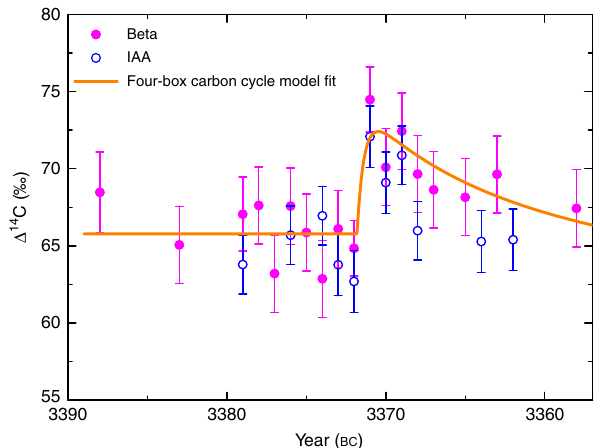
Fig. 1 Measured 14 C content. Measured results of Δ 14 C for the tree rings using the AMS method at the Beta Analytic radiocarbon dating laboratory ( fi lled circles) and the Institute of Accelerator Analysis laboratory (open circles). The typical error of a single measurement is about 2.5 ‰ for fi lled circles and 2.0 ‰ for open circles. In order to obtain a smaller error for this 14 C increase event, several measurements for BC 3371 and BC 3372 are performed. The solid line is the best fi t for fi lled circles using the four-box carbon cycle model with a net 14 C production of Q = (7.2 ± 1.2) × 10 7 atoms cm − 2 . Uncertainties (s.d.) are based on error propagation including measurement errors of the fraction of modern carbon F